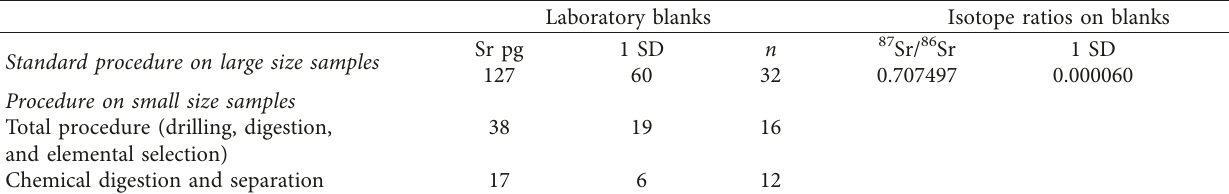
Figure 4: (a) Image of the laminar flow hood used for chemical processing and Sr separation of microdrilled samples; (b) image of quartz microcloumns filled with approximately 140 µ l of specific chromatographic resin (Eichrom Sr-Spec, 100–150 µ m) with high Sr-recovery efficiency, for Sr element extraction. Table 1: Blank contamination